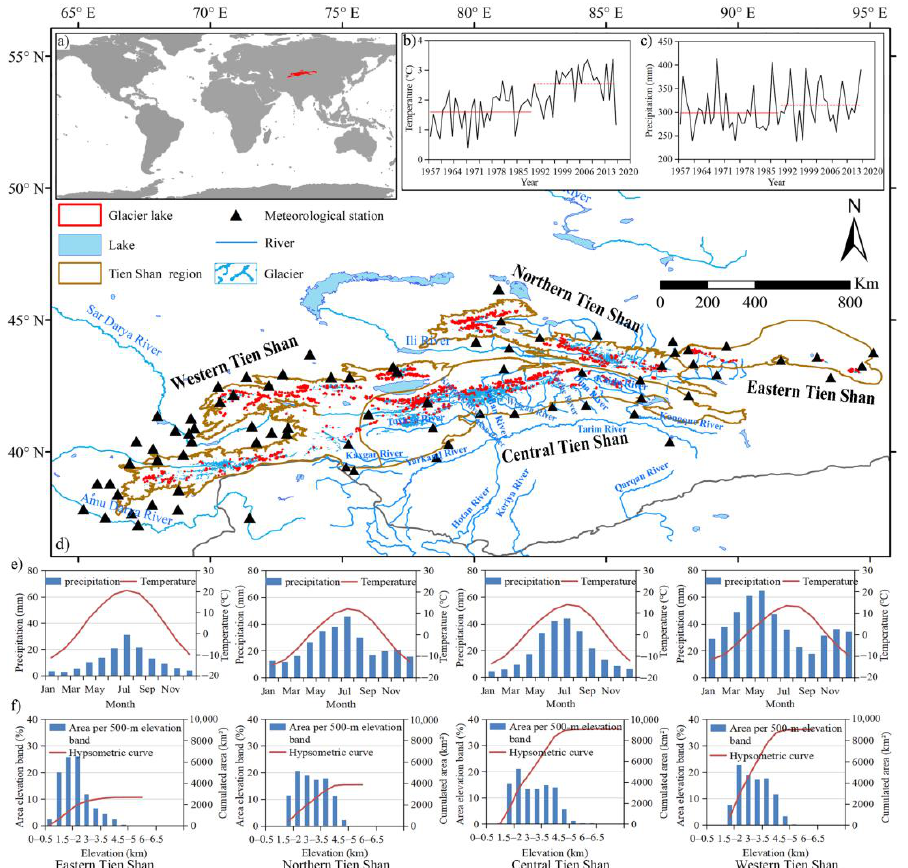
Figure 1. Map showing the TS study region ( a ); changes in annual temperature and precipitation ( b , c ); map of study area showing the spatial distribution of lakes, glaciers, rivers and meteorological stations ( d ); monthly average temperature (ERA-5) and precipitation (GPCC) ( e ); hypsometric curve of the TS region and distribution of the area by layer under each 500 m elevation band ( f ). Note: Jan = January, Mar = March, Jul = July, Sep = September, Nov = November. Based on their geographical positioning, the Eastern TS stretches from the eastern part of Hami City to the west of Fukang City and across the Harlik Mountains, Barkol Mountains and Bogda Mountains. The average elevation of the Eastern TS is 1624 m a.s.l., with the highest peak being Bogda Peak (5445 m a.s.l.), known in China as Bogada Feng. The Northern TS ranges from the eastern region of Yuergou, Turpan, in Xinjiang, crosses the western part of Zhetysu Alatau in Kazakhstan and has an average elevation of about 2521 m a.s.l. The Central TS starts in Gangou, Turpan, in Xinjaing, crossing the eastern part of the Hantengri and Artbash Mountains and the southern mountains of Issyk-Kul Lake to the west of the Fergana range in Kyrgyzstan. It possesses the highest mountains in the four TS regions with an average elevation of 2574 m a.s.l. Notable peaks include Tomor Peak (7443 m a.s.l.). Western TS covers the largest portion of the TS region, extending from northeastern Issyk-Kul Lake westward to the Kashkadarya and Surkhandarya regions of Uzbekistan; it has an average elevation of 2570 m a.s.l. (Table